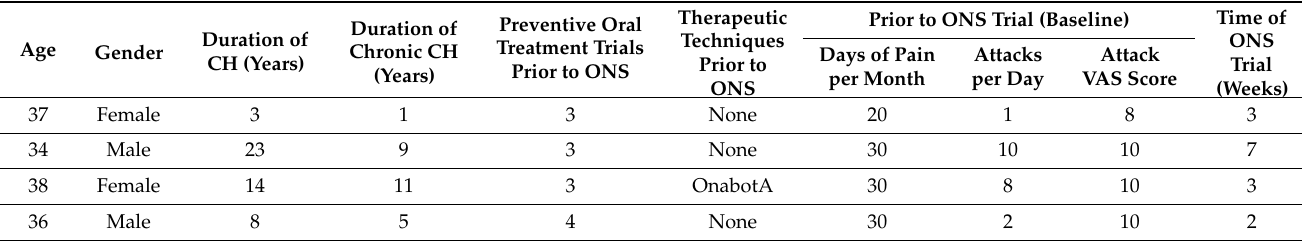
Table 1. Epidemiological and nosological characteristics of cluster headache patients who did not improve in the occipital nerve stimulation trial.